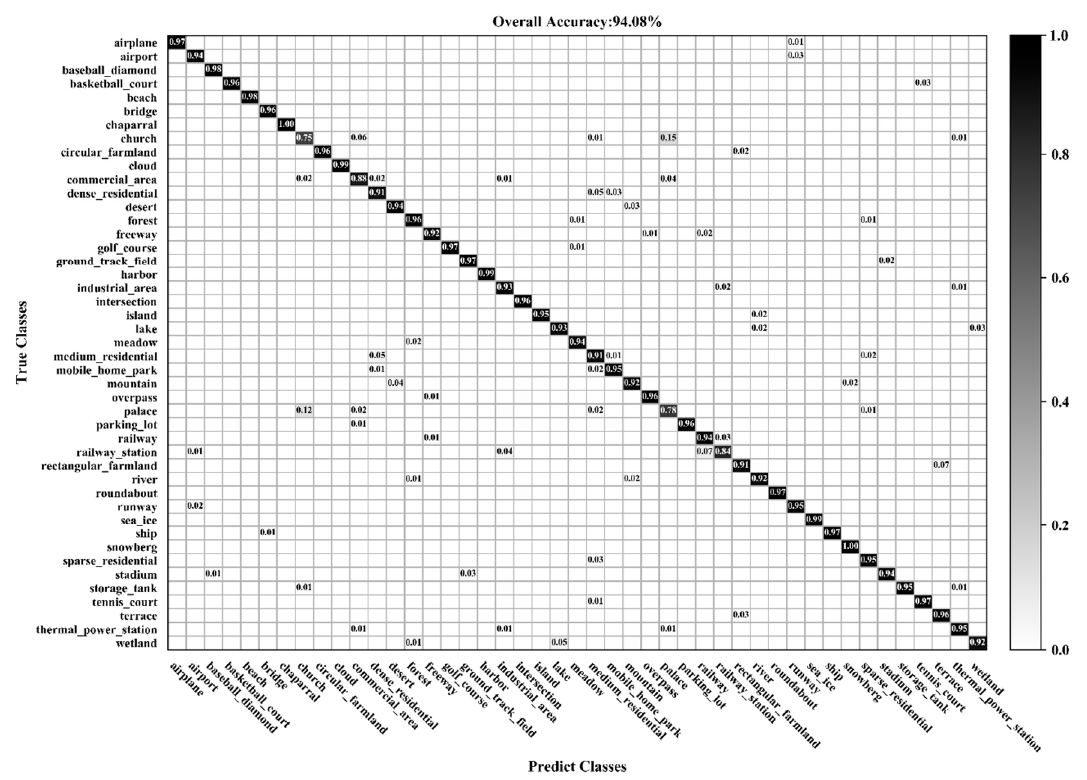
Figure 17. Confusion matrix using a training ratio of 20% on the NWPU-RESISC45 dataset.